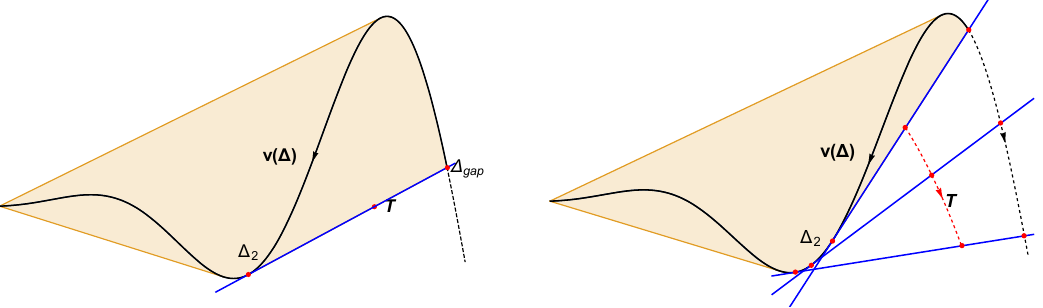
Figure 2 . On the left, the extremal case. The functional overlaps with a face of the convex hull of the vectors. On the right, we show how varying T smoothly, the extremal functional varies continuously, keeping tangent to H